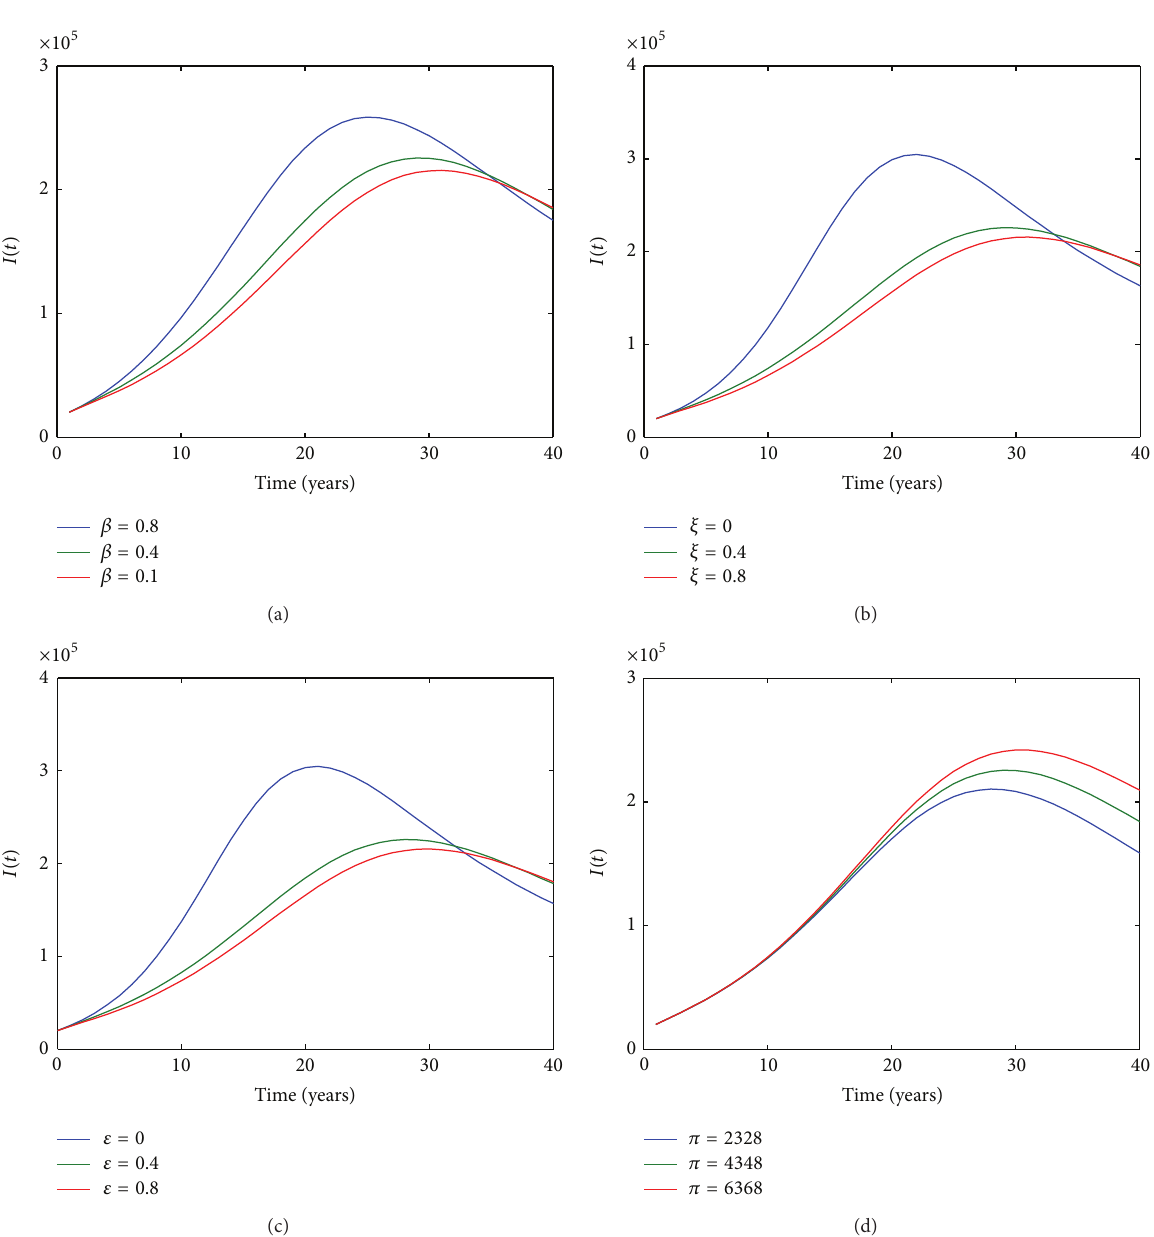
Figure 3: Variation in the number of HIV-positive individuals with different (a) transmission coefficient, (b) vaccination rate, (c) vaccine efficacy, and (d) recruitment